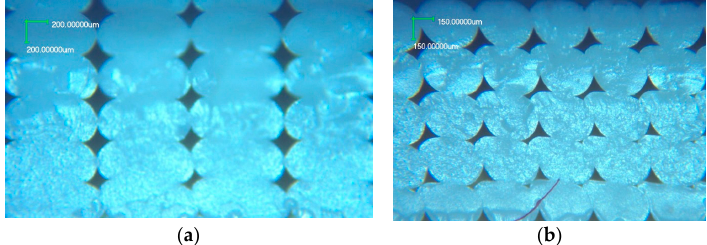
Figure 8. Mesostructure of the FDM processed part ( a ) bigger cross section of the road; ( b ) regular road shape with 20% overlap.